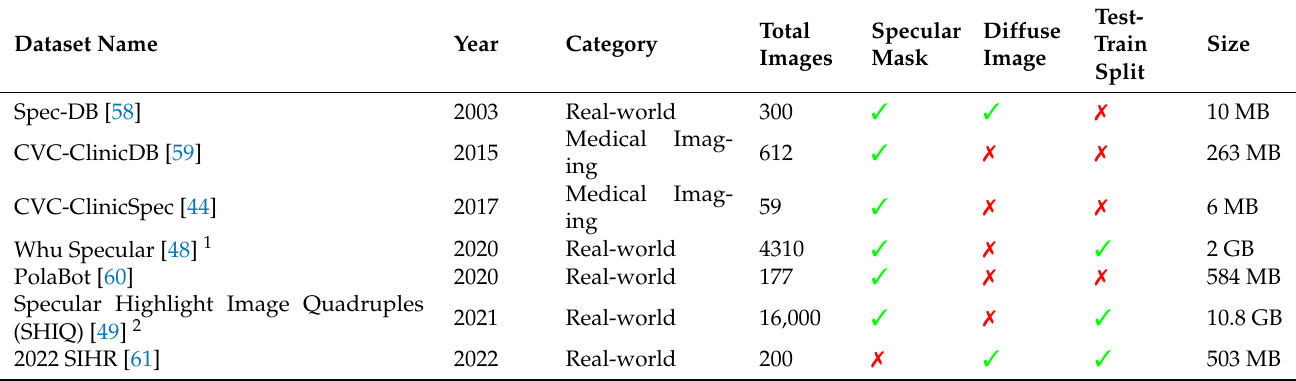
Table 3. List of specular imaging